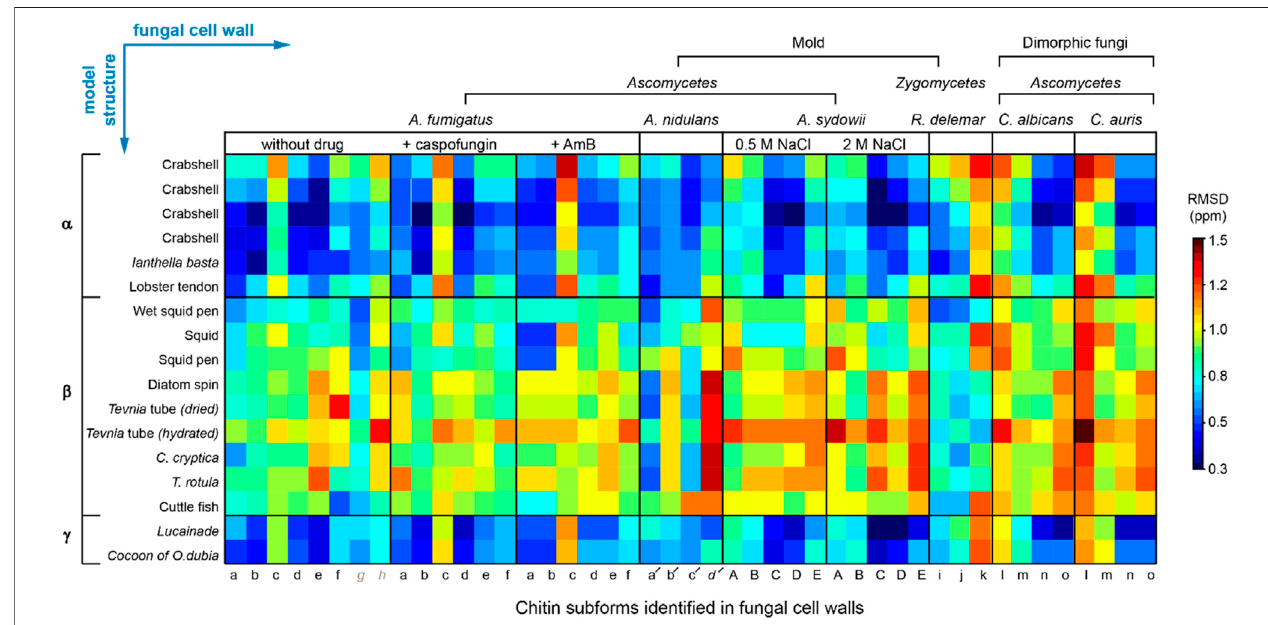
FIGURE 3 | 13 C chemical shift RMSD map comparing chitin structure. Data were compared between the observed 45 chitin forms in nine fungal cell walls ( x -axis) and the three crystalline forms reported byliterature ( y -axis).Datafrom sixfungal species wereshown, including three species of Ascomycetes ( A.fumigatus , Anidulans and A. sydowii ), asample from Zygomycetes ( R.delemar ),and twoAscomycetes yeastspecies ( C. albicans and C. auris ).Most chitin types showed similarity to α -chitin form. The color scale is shown, with units of ppm. Good correlation with RMSD less than 0.5 ppm (within NMR linewidth) are in dark blue. The forms with certain ambiguous carbon sites are labeled in italics and grey. The chemical shift values used for the analysis are provided in Supplementary Tables S2, S3 .